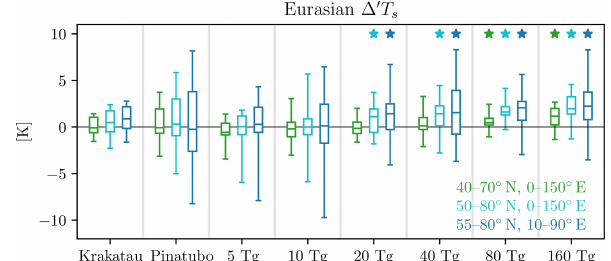
Figure 7. Eurasian surface temperature anomalies, computed us- ing the difference-from-reference-period method, for the first win- ter following the indicated eruptions for both, two historical simu- lations and for the EVA. Colors indicate different averaging regions over Eurasia, as shown in the legend. Boxes show the upper and lower quartiles, central bars the median, and whiskers the ensem- ble maximum and minimum. Stars denote statistically significant responses at the 95% confidence